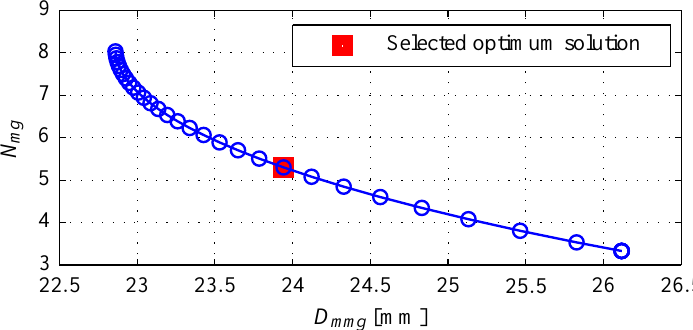
Figure 20. Pareto front constructed from the multiobjective optimization results.